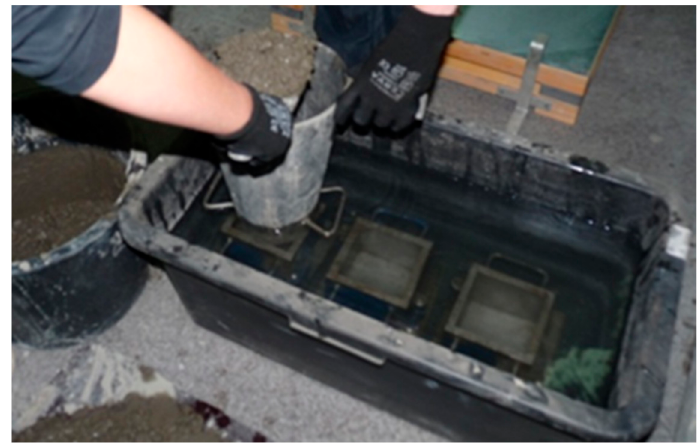
Figure 2. Preparation of specimens for strength testing.